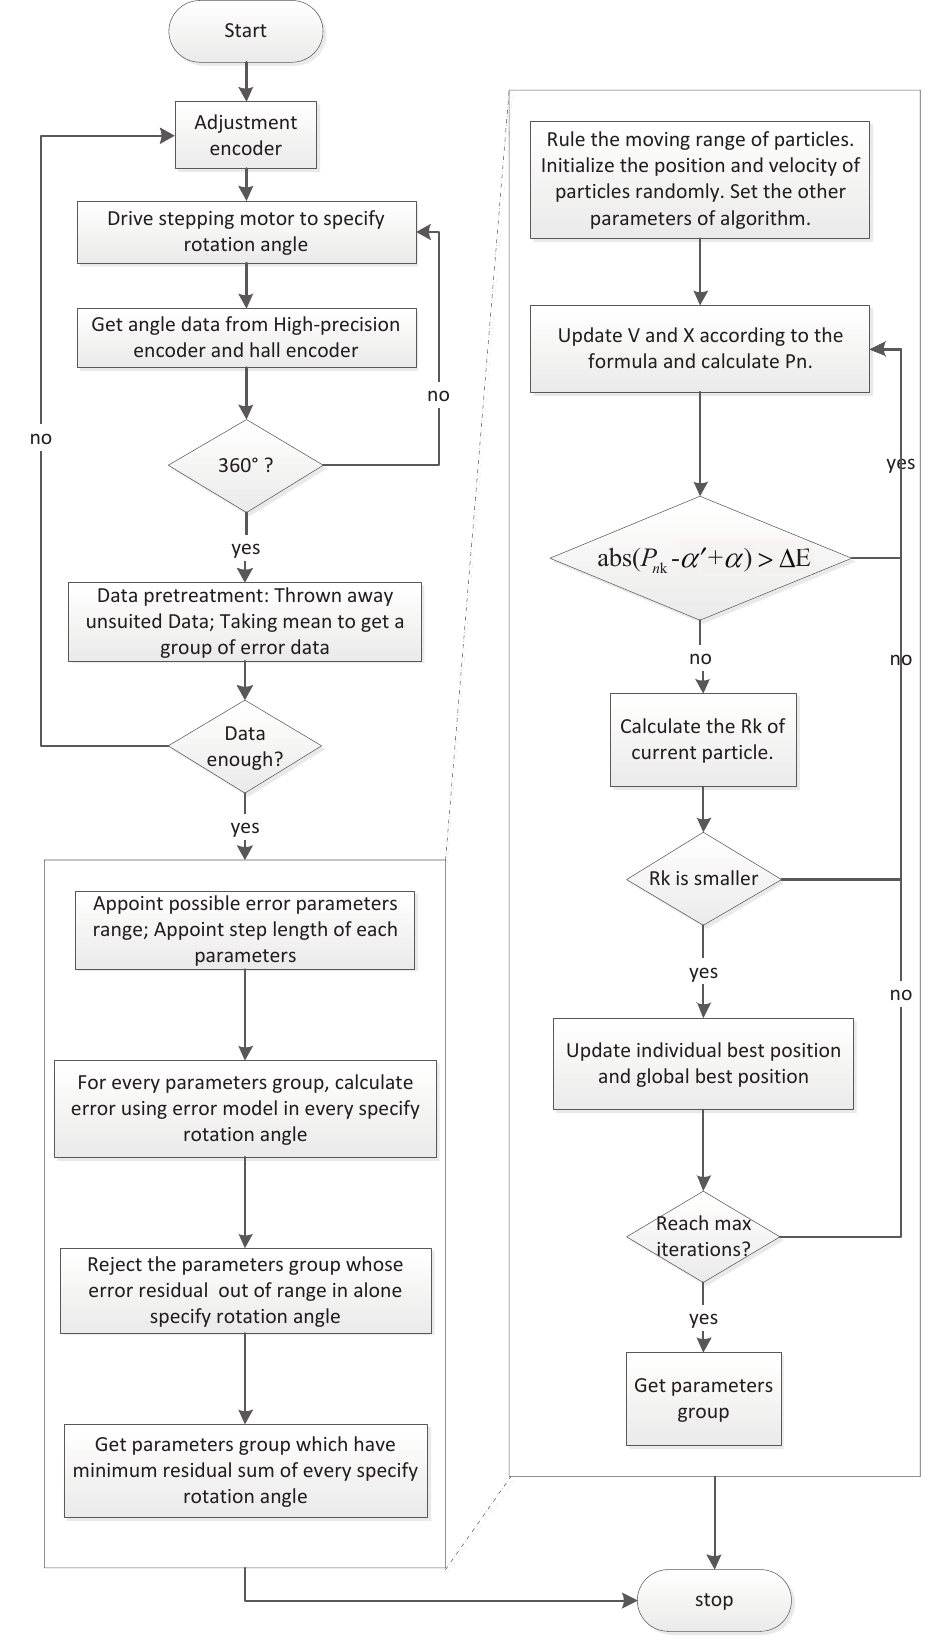
Figure 12. The flow chart of the rapid diagnosis method. ( Left ) The ordinary method; ( right ) the method using particle swarm optimization